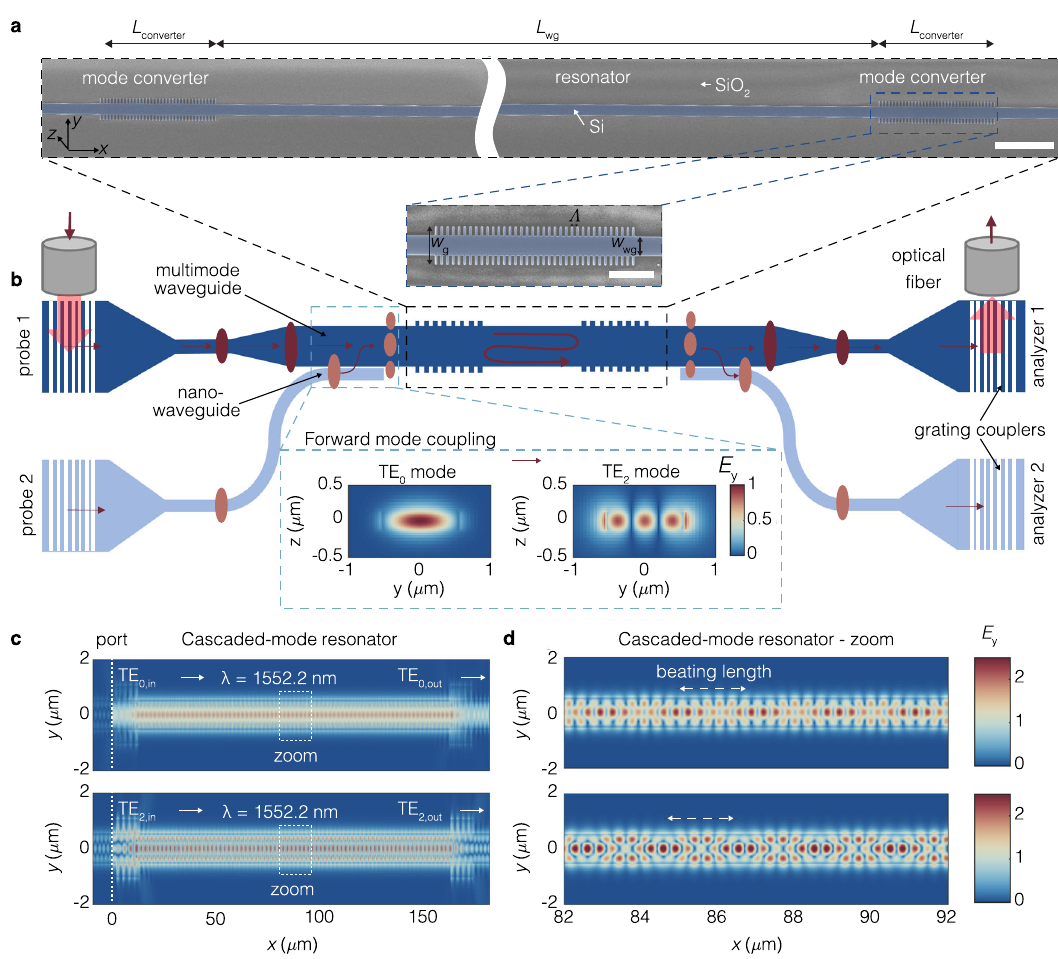
Fig. 3 | The experimental realization of cascaded-mode resonators in inte- gratedphotonics.a SEMpicturesofthecascaded-moderesonatorshowtwomode converters connected via a multimode waveguide of width w wg and length L wg . Multimode waveguides located before and after the resonator guide telecom light into and outside the resonator. The mode converters are realized by corrugating thesiliconwaveguidelaterallyintotheshapeofarectangulargratingofperiodicity μ m and 2 μ m (inset). The periodicity Λ is chosen such Λ and width w g . Scalebar=5 that the phase-matching condition is satis fi ed for contra-directional coupling. The entire photonic circuit ridge is buried into a silica layer. b Schematic of the device showsthreedifferentsections:1.twoinputwaveguides(left)thatallowtoprobethe resonatorwitheitherTE 0 (upper)orTE 2 (lower), 2. theresonator region consisting of the multimode waveguide enclosed by the two mode converters, and 3. two analyzer waveguides which transmit the output of the resonator into two spatially separatedlocations,dependingonitstransversepro fi leTE 0 (upper)orTE 2